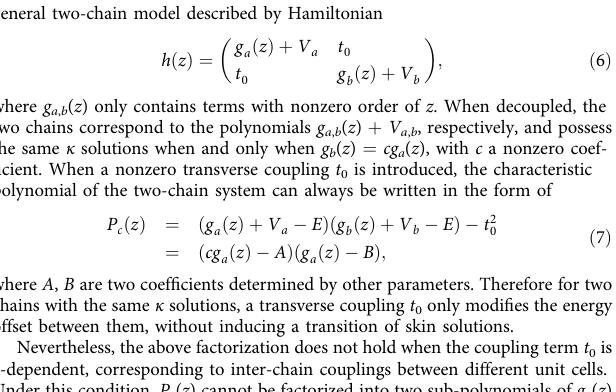
Fig. 4b, the fi nite-size OBC spectrum (gray dots) qualitatively agrees with the decoupled E ∞ (green), with a real-valued gap at E = 0 along the Im ½ E (cid:3) ¼ 0 axis (inset). Upon the size increase to N = 30 and then to N = 40, such a gap fi rst closes on the complex plane and then develops into a point gap with two zero-energy degenerate modes lying in its center. The Z -type topological origin of such in-gap modes is also carefully veri fi ed in Supplemen- tary Note 5. The gap closure and then the emergence of in-gap topological modes resemble the typical behavior of a topological phase transition. Yet, here it is an intriguing size-induced effect. Further, the emergence of in-gap modes only requires exponentially weaker inter-chain coupling (i.e., smaller δ ab / δ a ) for larger N , as shown in the “ phase ” diagram shown in Fig.